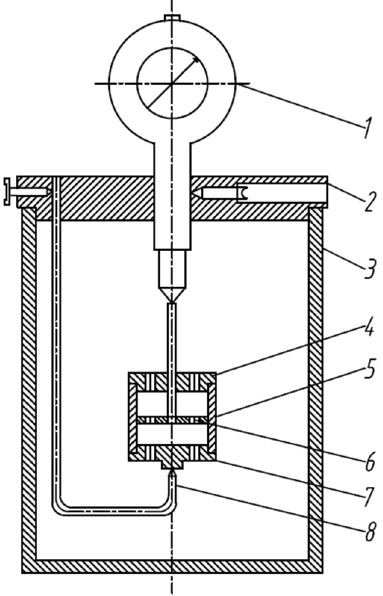
Figure 11. Zhigach–Yarov device: 1—dial gauge; 2—instrument cover; 3—glass; 4—measuring cell cover; 5—measuring cell; 6—piston; 7—bottom of the measuring cell; 8—bracket. When processing the data, the highest sensor indicators for the entire period were selected, and both coefficients were calculated. The results of the calculation are shown in Figure 12, and coefficients describe the effect of the liquid on the swelling of the core material in different ways.